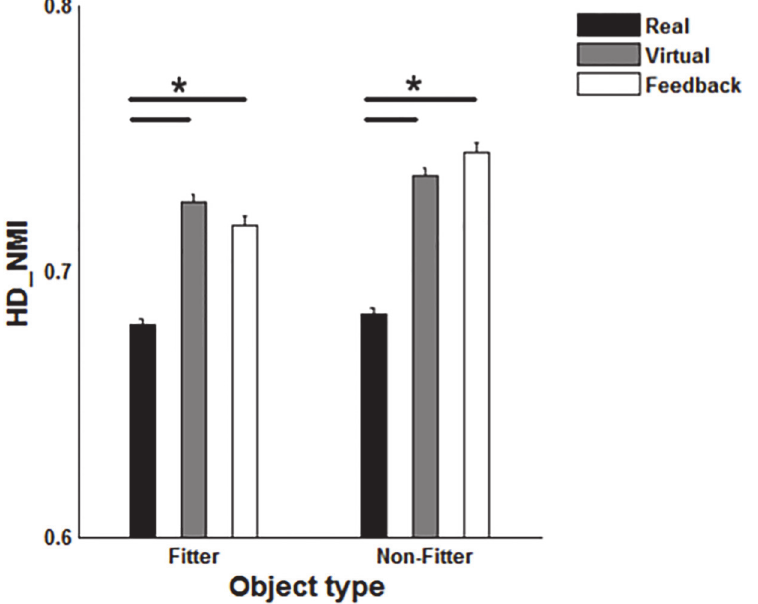
Fig 6. The mean and standard error of normalized mutual information within real, virtual and virtual with force feedback environment (Real, Virtual and Feedback) for fitter (A) and non-fitter objects (B). For an arbitrary subject ( S i ), we computed inter-subject similarity NMI ( RE S electromyography map for i-th subject and the representative electromyography map across the subject pool, respectively (Real). The intra-subject similarity was computed across the virtual platforms NMI ( RE S ,VEF S NMI ( RE S ), for virtual and virtual with force feedback (Feedback) environments, respectively. * indicate i i a significant pairwise comparison between Real, Virtual and virtual environment with feedback (Feedback) (p <